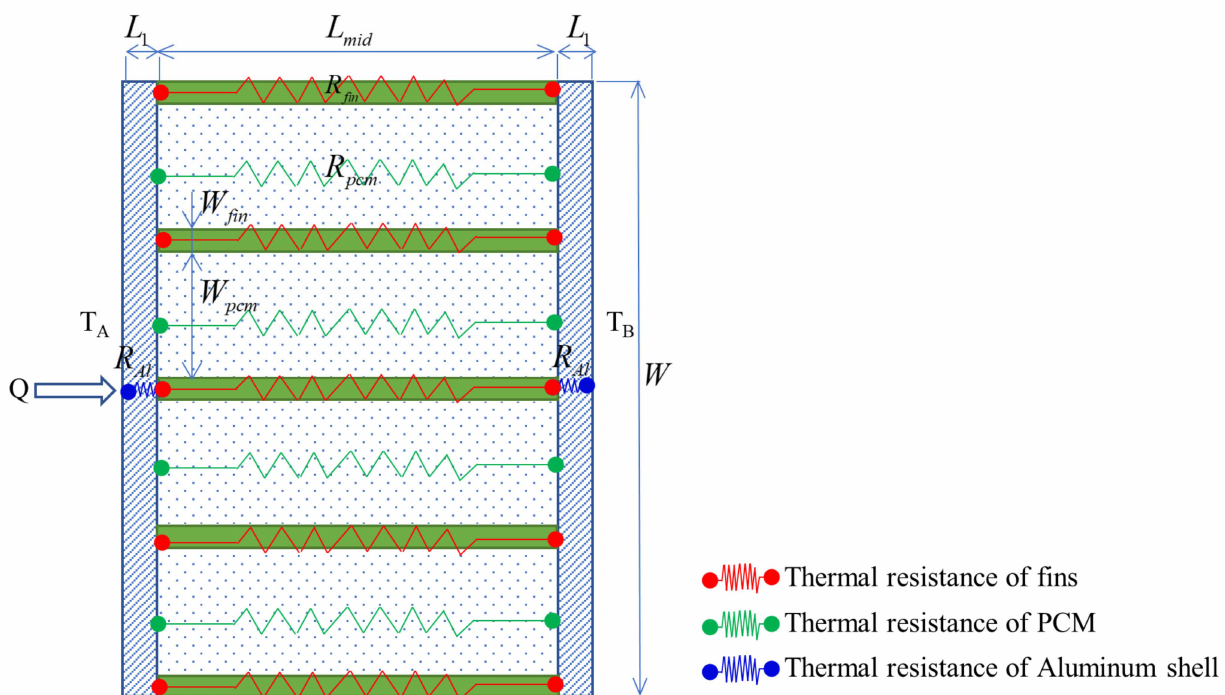
Figure 9. Thermal resistance model of PCM